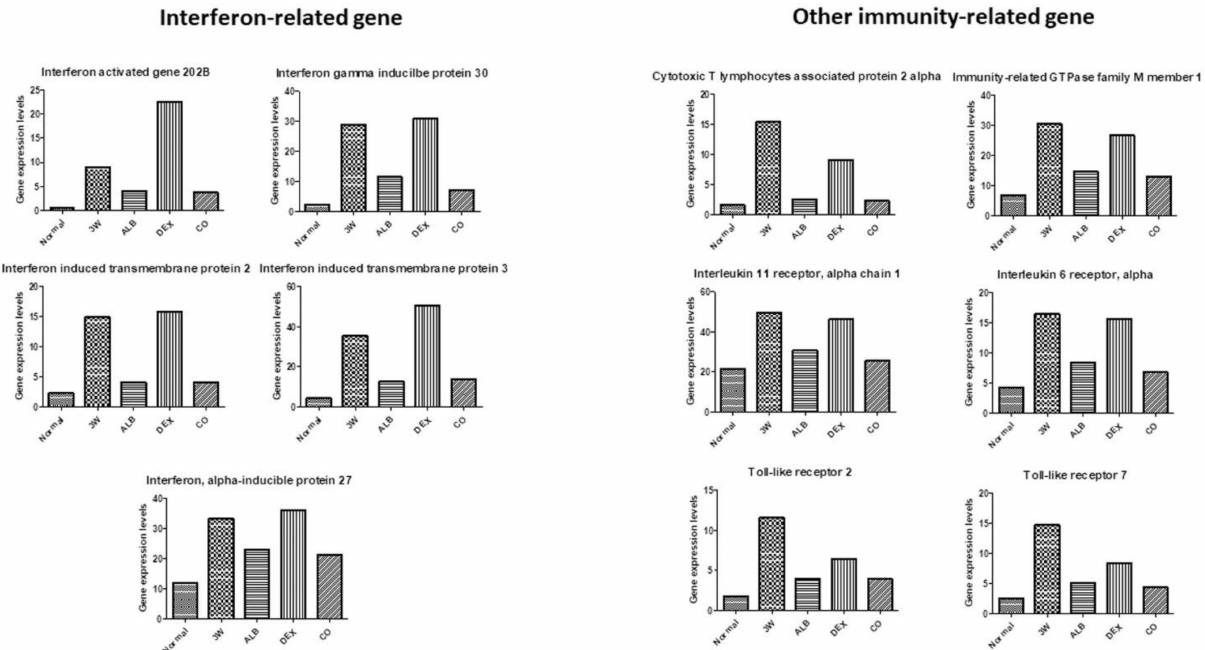
Figure 15. RNA-seq data of interferon-related and other immunity-related genes after treatment of albendazole alone dexamethasone alone, and co-therapy of the two drugs to BALB/c mice infected with Angiostrongylus cantonensis .